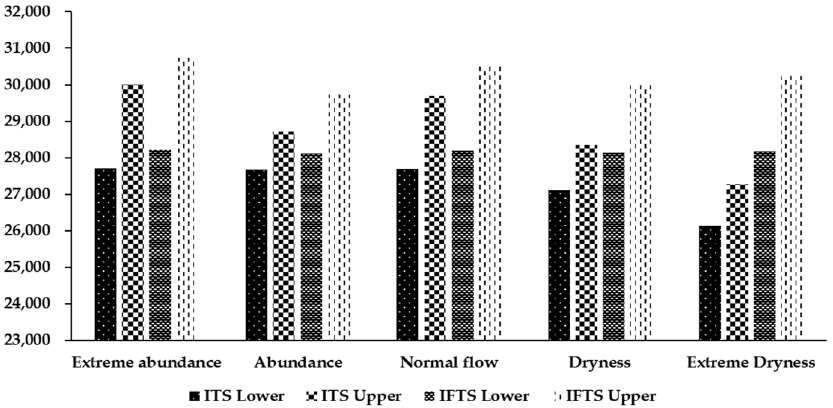
Figure 6. Comparison of the eco-compensation effect due to the interval value optimization model using the ITS model and the IFTS model ( × 10 4